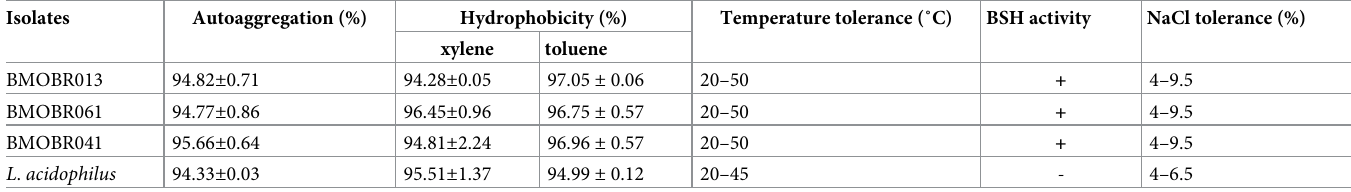
Table 1. Primary probiotic characteristics of lactic acid bacterial (LAB) strains.